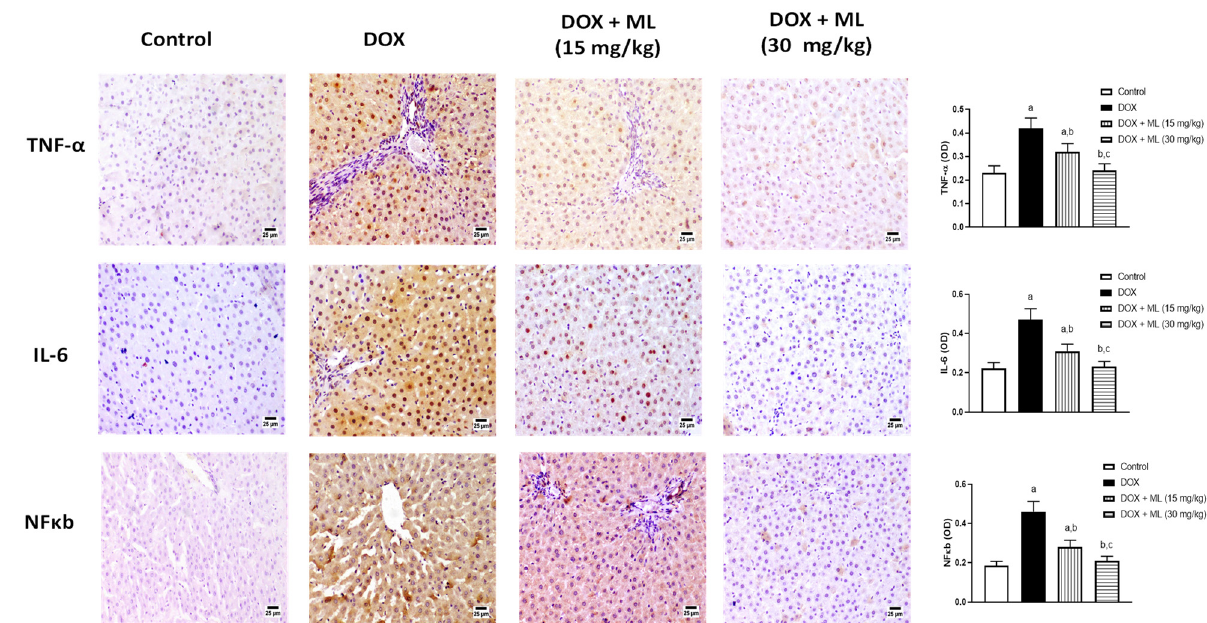
Figure 6. Immunohistochemical photomicrographs of liver sections demonstrating the effect of ML on DOX-induced alterations in IL-6, TNF- α and NF κ B. Data presented in bar charts are Mean of optical densities ± SD ( n = 6). a, b or c: Statistically different from Control, DOX or DOX + ML (15 mg/kg), respectively at p < 0.05.